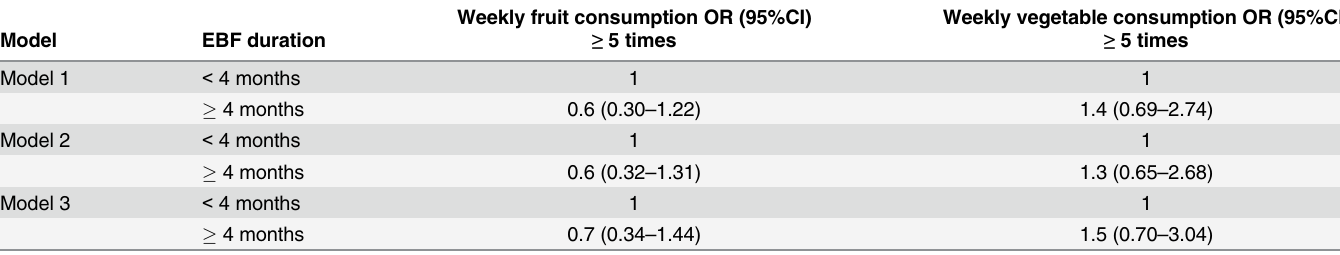
Table 3. Duration of exclusive breastfeeding and weekly consumption of fruits and vegetables at 4 – 7 years old.